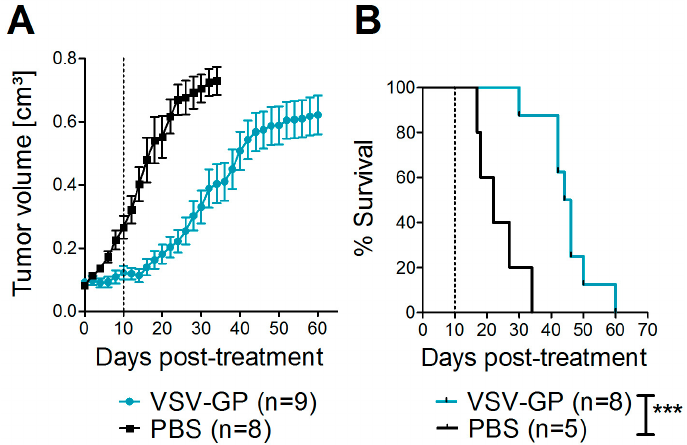
Figure 2. VSV-GP prolonged the survival of mice with human melanoma xenografts. A375 human melanoma cells were implanted subcutaneously into NOD/SCID (NOD.CB17-Prkdcscid/J) mice. Tumor growth was measured every two days using a caliper. When tumors reached 0.07 cm 3 in volume, they were treated with either 10 7 plaque forming units (PFU) of VSV-GP in 30 µ L PBS, or mock-treated with 30 µ L of PBS. A second round of treatment was given 10 days after the first treatment. Mice were euthanized when tumors reached a volume of 0.8 cm 3 . The mean ± SEM of tumor size ( A ) and % survival in a Kaplan–Meier curve ( B ) are shown. Dotted lines indicate the time point of the second treatment. *** p = 0.0004, Log-rank (Mantel–Cox) test.